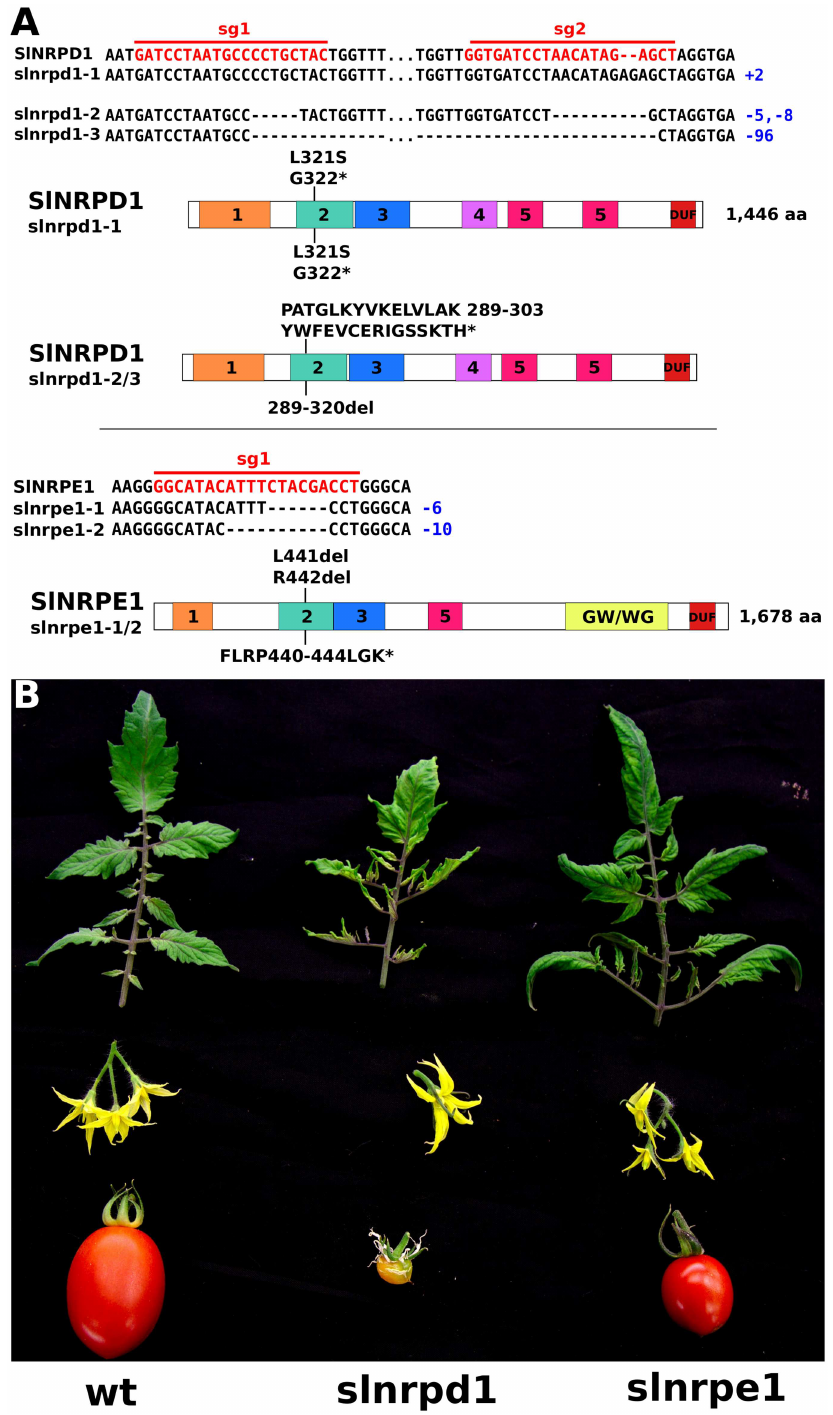
Fig 3. Genotype (A) and phenotype (B) of tomato slnrpd1 and slnrpe1 mutants used in this study. The sequencesof the sgRNAs (sg1 and sg2) guidingCRISPR-mediatedgene editing are indicatedin red. Protein domainspredicted by HMMER are depicted:domains1–5 correspondto RNA polymeraseRpb1 domains 1–5; DUF, domainof unknownfunction.